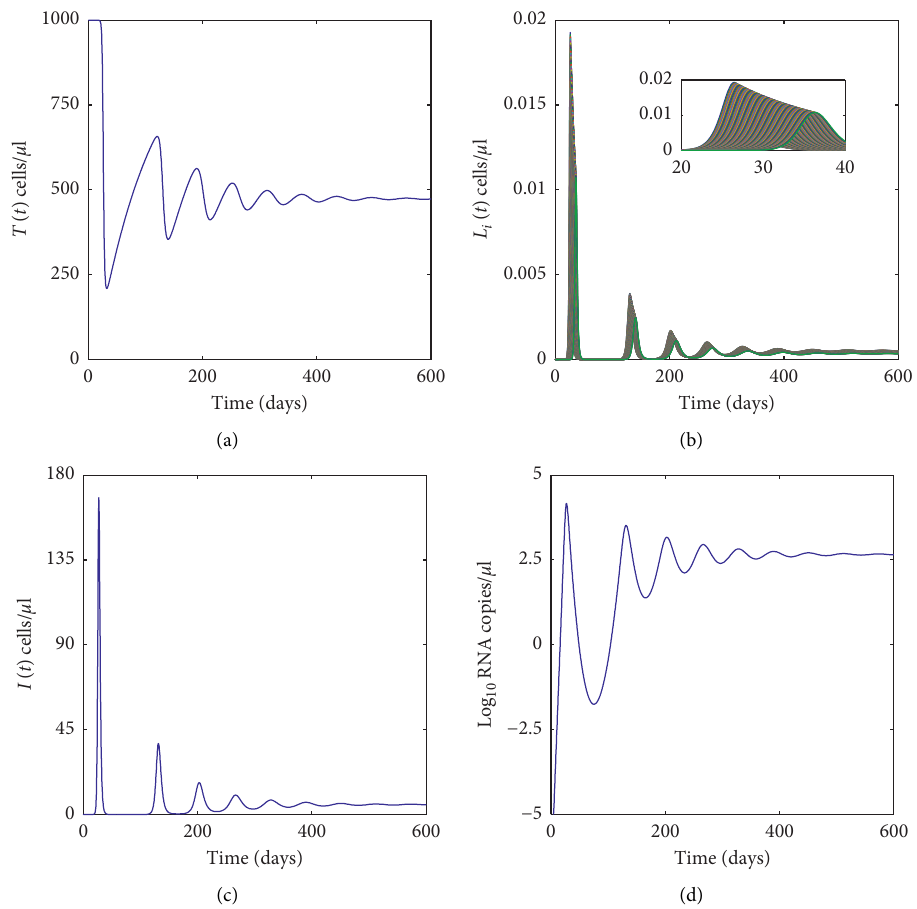
Figure 2: Predicted dynamics of uninfected CD4 + Tcells, latently infected CD4 + Tcells, productively infected CD4 + Tcells, and viral load of the model before therapy. Using the parameter values given in the text, we have R E ∗ is